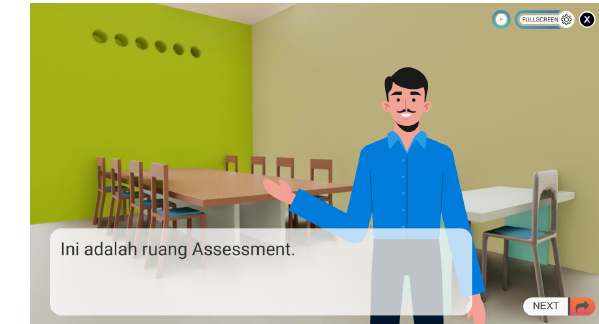
Figure 9: Assessment